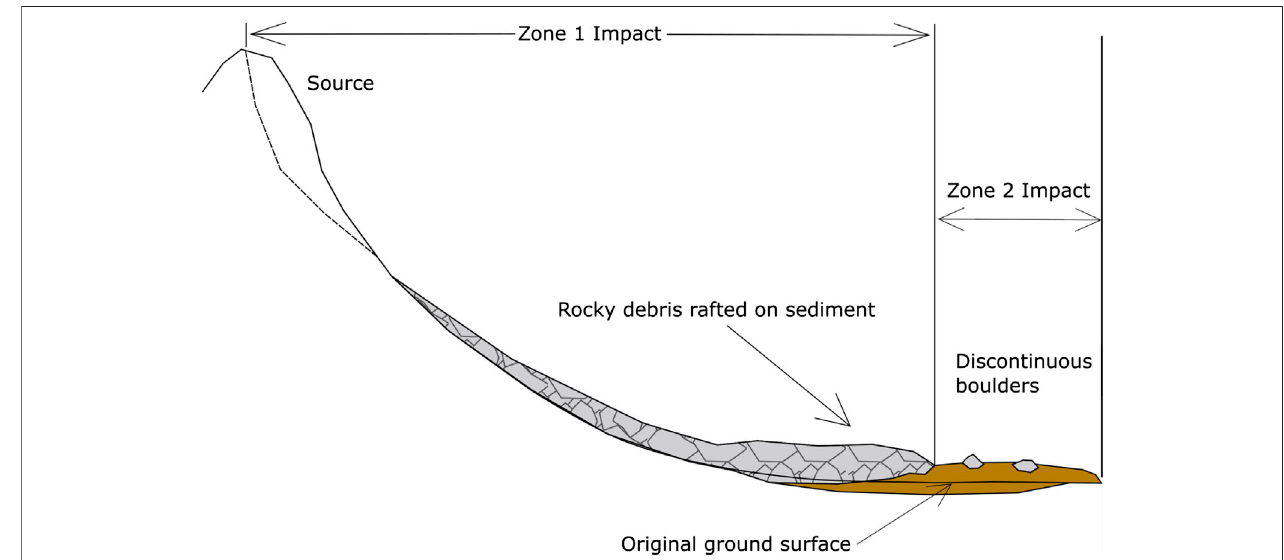
FIGURE 3 | De fi nition sketch showing Zone 1 and Zone 2 impacts from a rock avalanche.